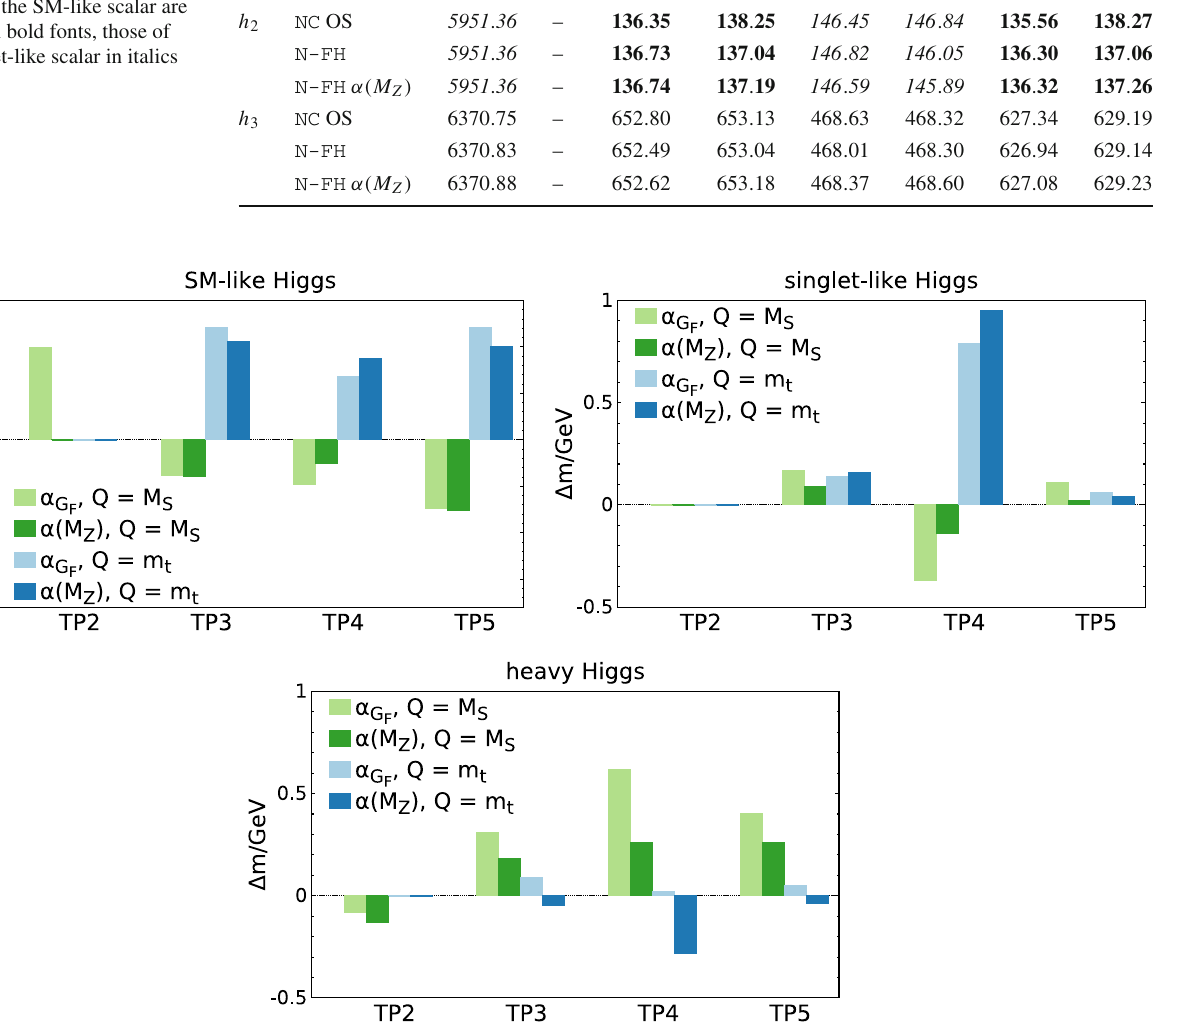
Fig. 3 One-loop difference (cid:9) m = M NC the reparametrization to α G